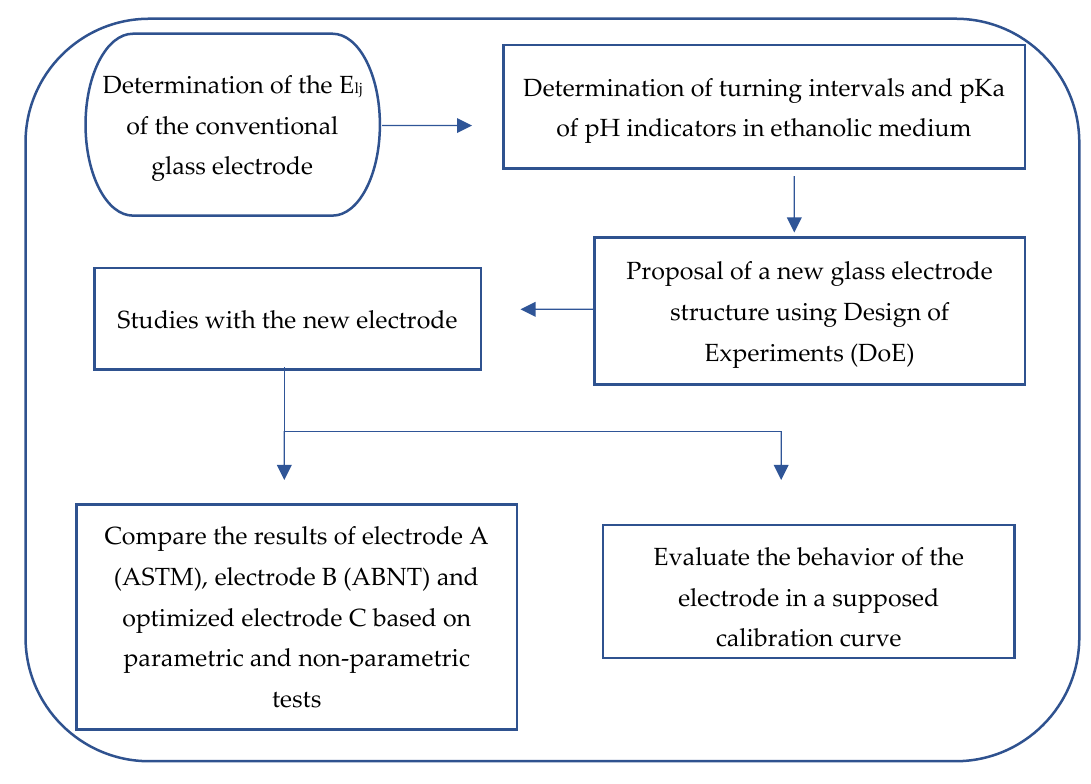
Figure 1. Experimental flowchart.